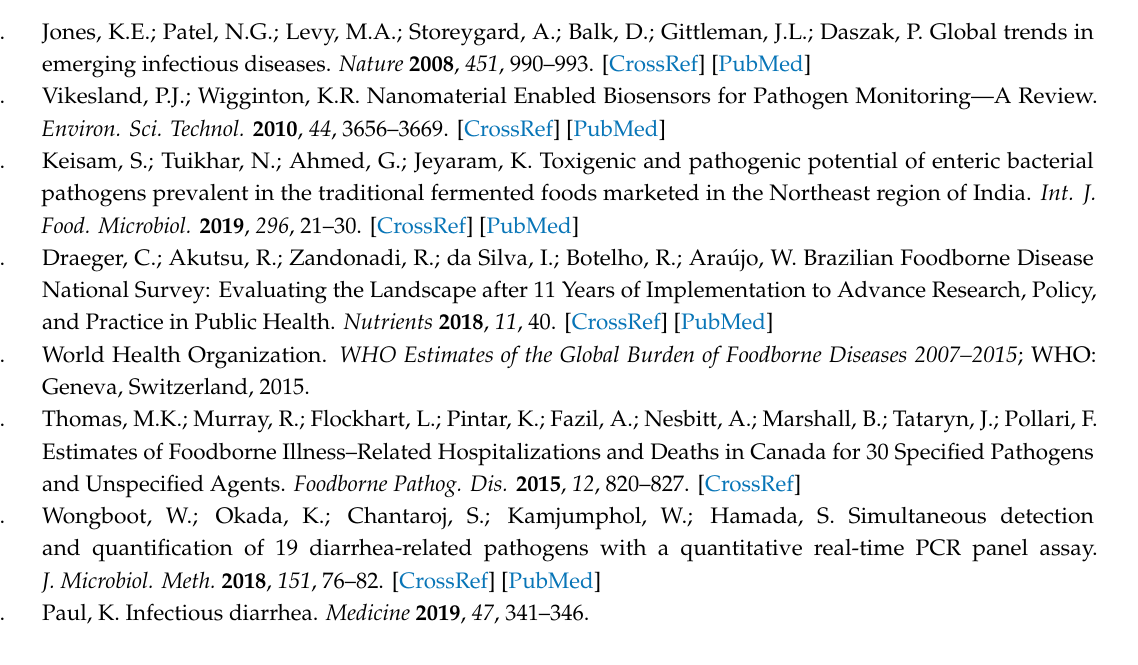
Figure S1: Determination of optimal lysing time on